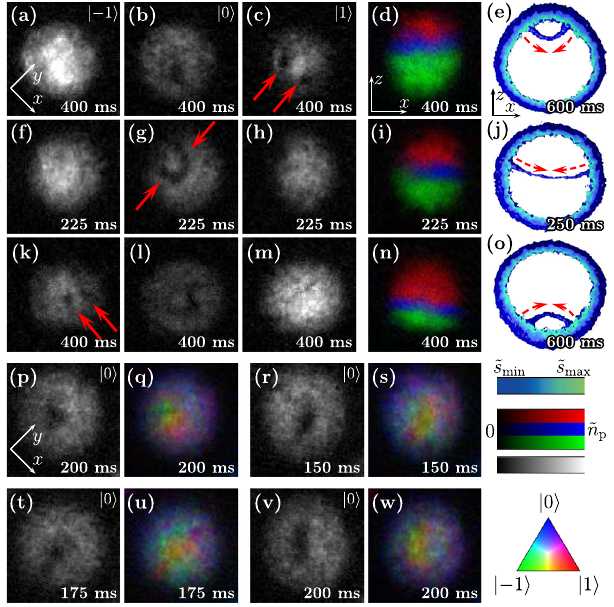
FIG. 4. Experimental column particle densities of − z -quantized spin states showing nodal lines associated with the Dirac monopole. In (a – o), the first, second, and third columns corre- spond to the top images of ζ − 1 , ζ 0 , and ζ spinor components, þ 1 respectively; the fourth column shows the related composite side images; and the fifth column shows the corresponding numeri- cally obtained spin densities ~ s ¼ j Ψ † F Ψ j before the projection ramp. In (a – e), the monopole is located in the upper half of the condensate, in (f – j) in the middle, and in (k – o) in the lower half. The solid red arrows in (c,g,k) indicate the locations of the nodal lines, and the dashed red arrows in (e,j,o) indicate the direction of the vorticity of the nodal line. In (p – w), each set of two adjacent images is extracted from an individual experiment in which the monopole is located in the middle of the condensate, such that (p,r,t,v) show the column particle density of the ζ 0 spinor component and (q,s,u,w) show the corresponding composite top image, respectively. The data for (p,q) are the same as in Fig. 2(g). The hold times are indicated in the bottom-right corner of each panel. The fields of view are as in Fig. 2, and the peak 5 . 0 × 10 8 cm − 2 , particle densities are (a – c,f – h,k – m,p,r,t,v) ~ n p ¼ 8 . 5 × 10 8 cm − 2 , and (q,s,u,w) ~ n 1 . 0 × 10 9 cm − 2 . (d,i,n) ~ n p ¼ p ¼ The simulation data in (e,j,o) is shown for a region of 15 × 15 μ m 2 with a thickness of 5 . 8 μ m along y . The shown minimum 2 . 1 × 10 8 cm − 3 and and maximum spin densities are ~ s min ¼ ~ s 10 . 1 × 10 8 cm − 3 max ¼